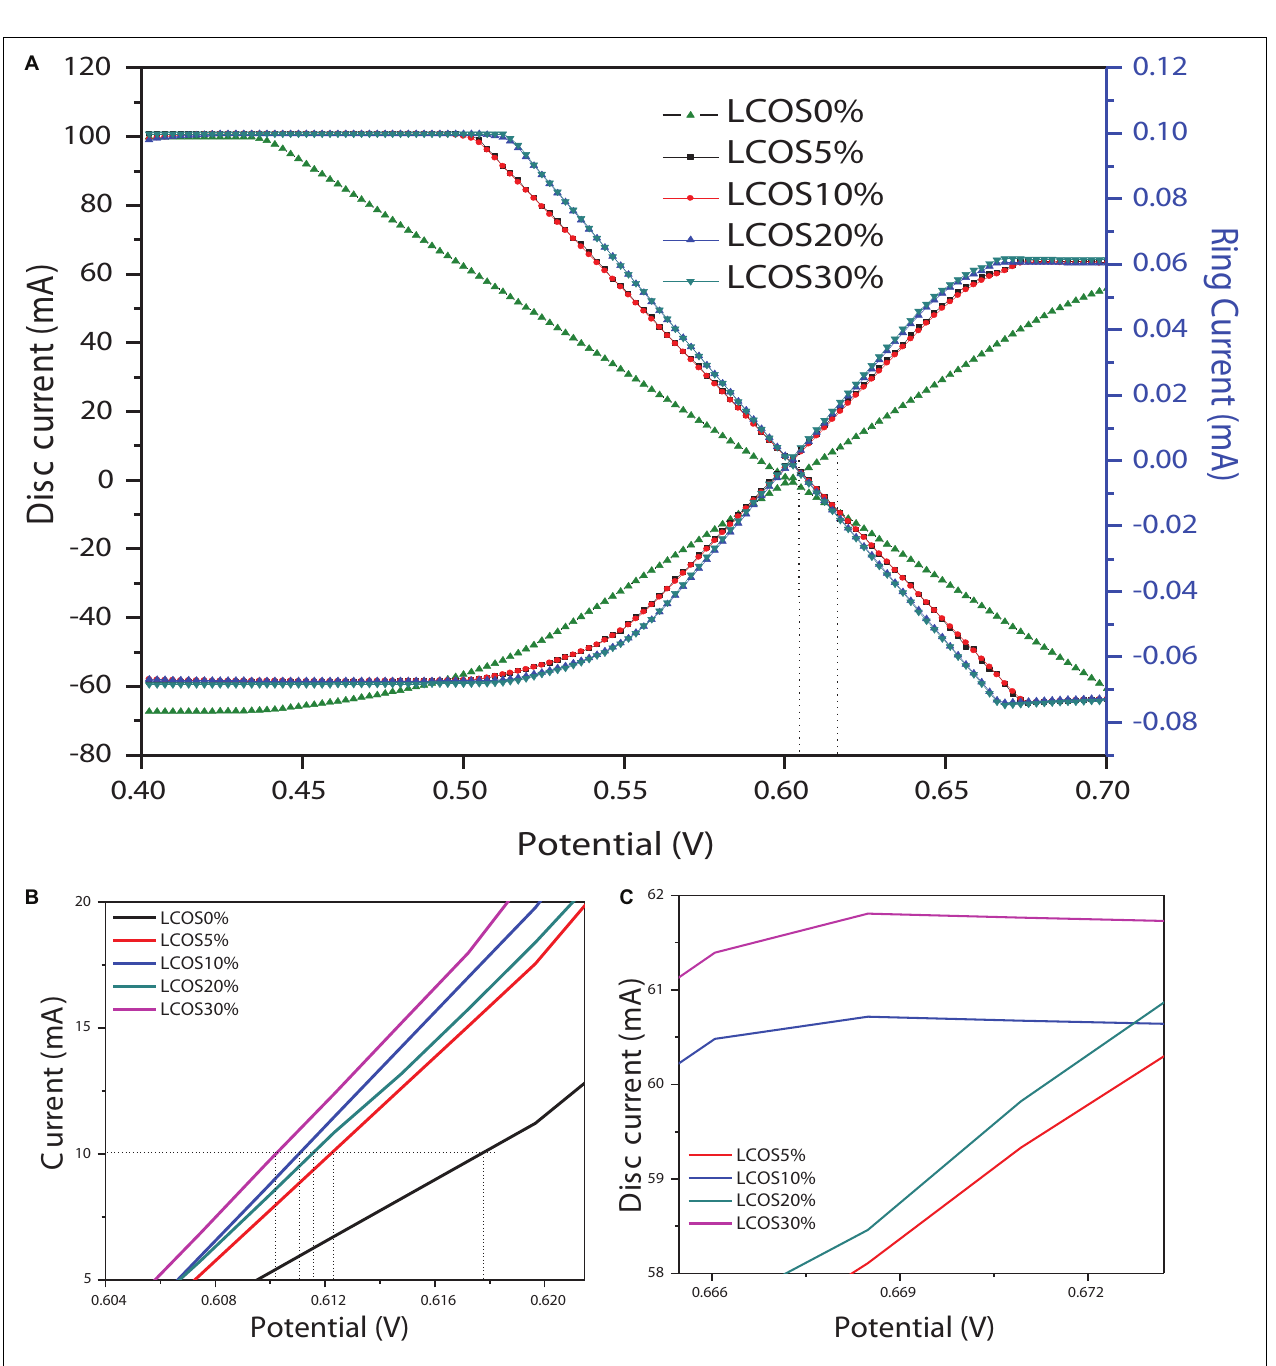
FIGURE 6 | (A) Linear sweep voltammetry on RRDE (rotating ring disc electrode) shows OER activity of the LSCO0%, LSCO5%, LSCO10%, LSCO20% and LSCO30% samples at 5 mV/sec in 0.5M H 2 SO 4 . Zoomed parts of (A) : (B) potential range and (C) disc current.